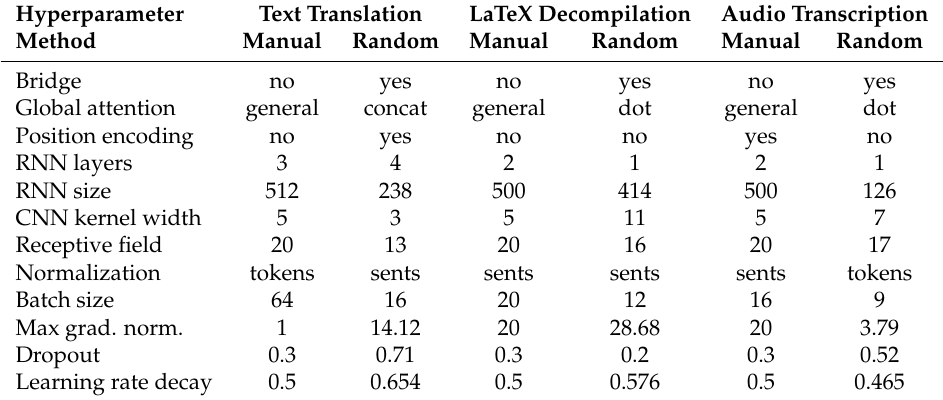
Table 1. Hyperparameters of the encoder-decoder networks used in the three problems of interest. Bridge: add a dense layer between encoder and decoder. Global attention: score function used in the attention model. Position encoding: add position information in the encoding. RNN layers: number of layers in the RNN of the decoder. RNN size: number of units in each layer of the RNN. CNN kernel width: size of the convolution filters in CFE. Receptive field: selected receptive field for the CFE. Normalization: method used to normalize the gradients. Batch size: size of the batches used in the training. Max grad. norm.: maximum allowed norm of the gradient. Dropout: dropout rate used. Learning rate decay: value applied to reduce the learning rate.